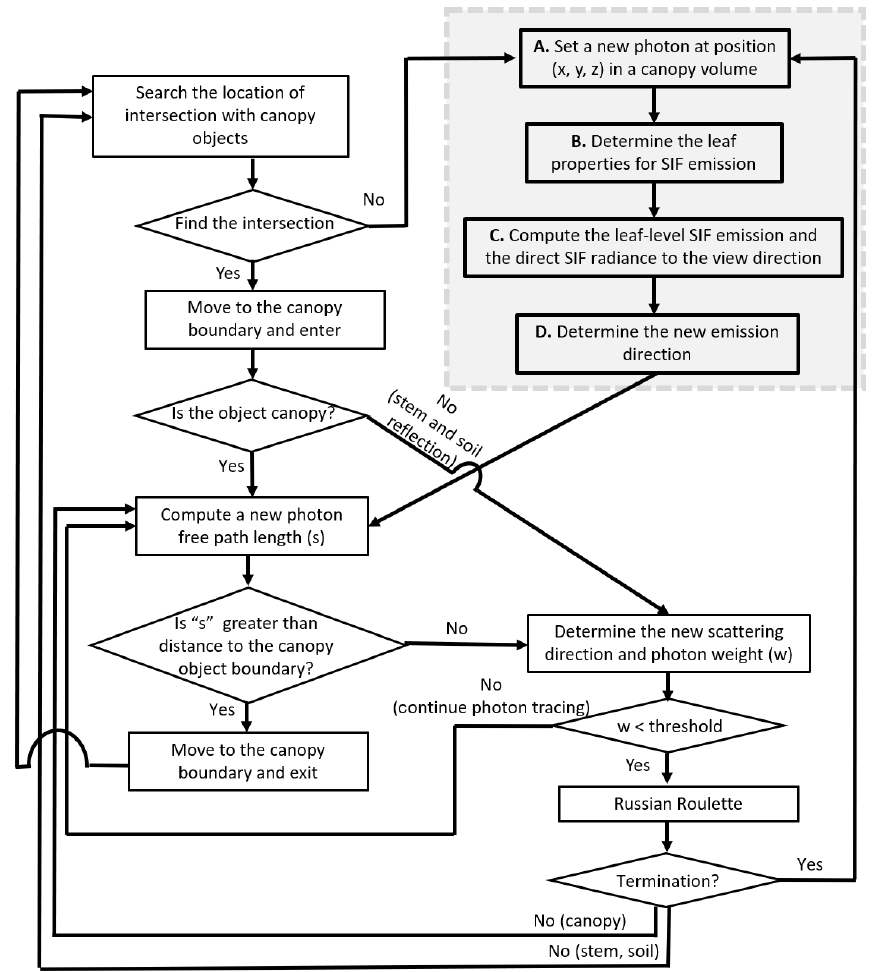
Figure 4. The flowchart of the Monte Carlo photon-tracing scheme in canopy landscapes at a single wavelength. Procedures A to E, framed by the dotted grey rectangle, indicate the photon-tracing scheme for direct SIF emission. The other part of the flowchart corresponds to multiple scattering. The multiple scattering schemes are the same as the original FLiES model (Kobayashi and Iwabuchi,